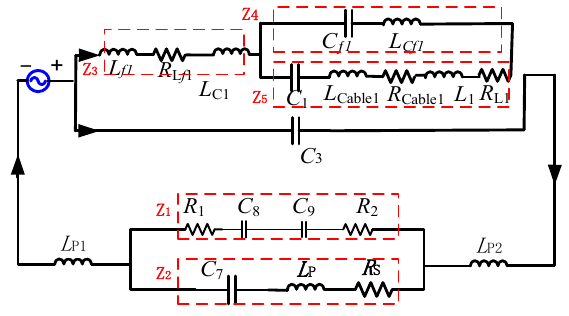
Energies 2017 , 10 , x FOR PEER REVIEW Figure 12. Analysis for DM interference: Equivalent circuit diagram. Figure 12. Analysis for DM interference: Equivalent circuit diagram.